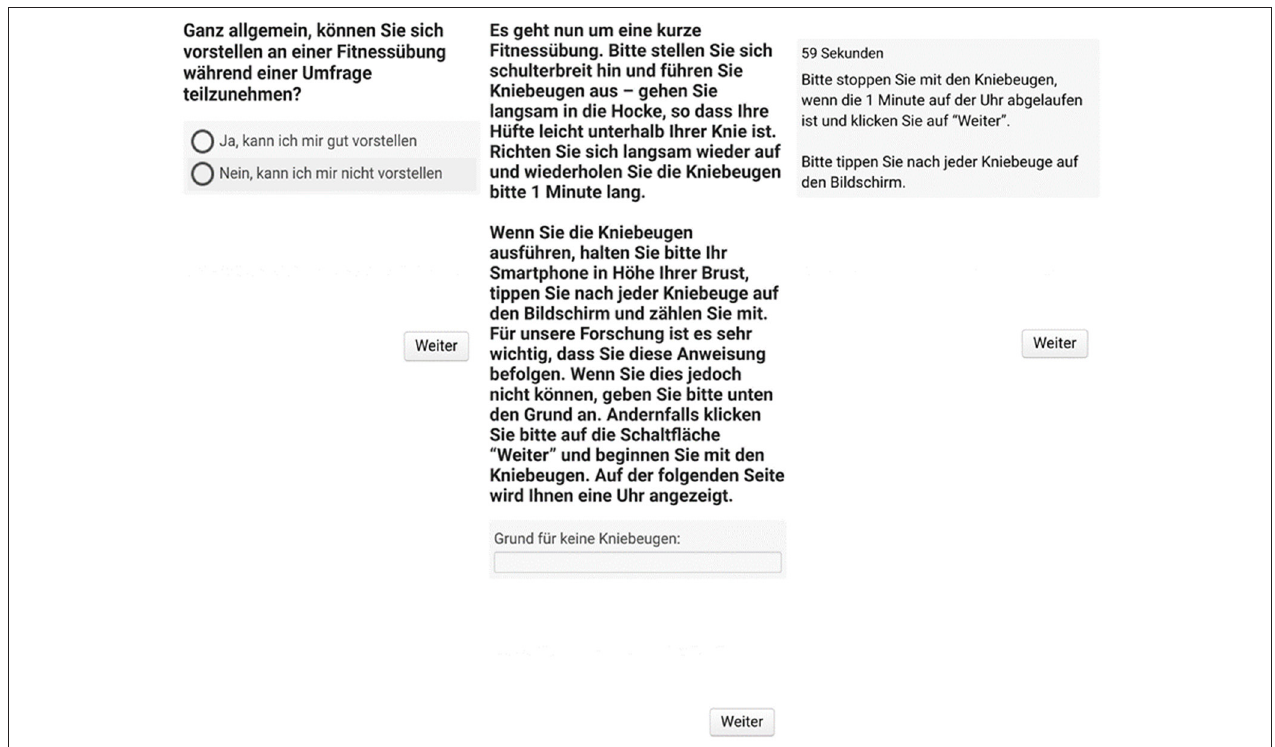
FIGURE 1 | Screenshots for hypothetical compliance (on the left), observed compliance including squat instruction (in the middle), and the timer page for doing squats (on the right). The German versions of all questions and instructions are available from the second author on request.